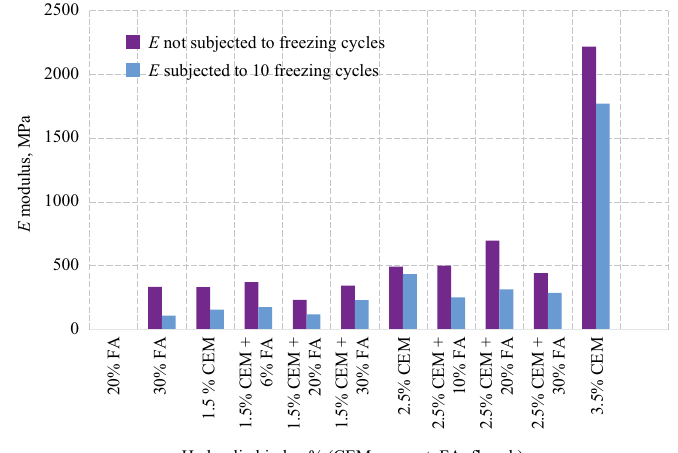
Figure 5. E modulus values for reference samples and after